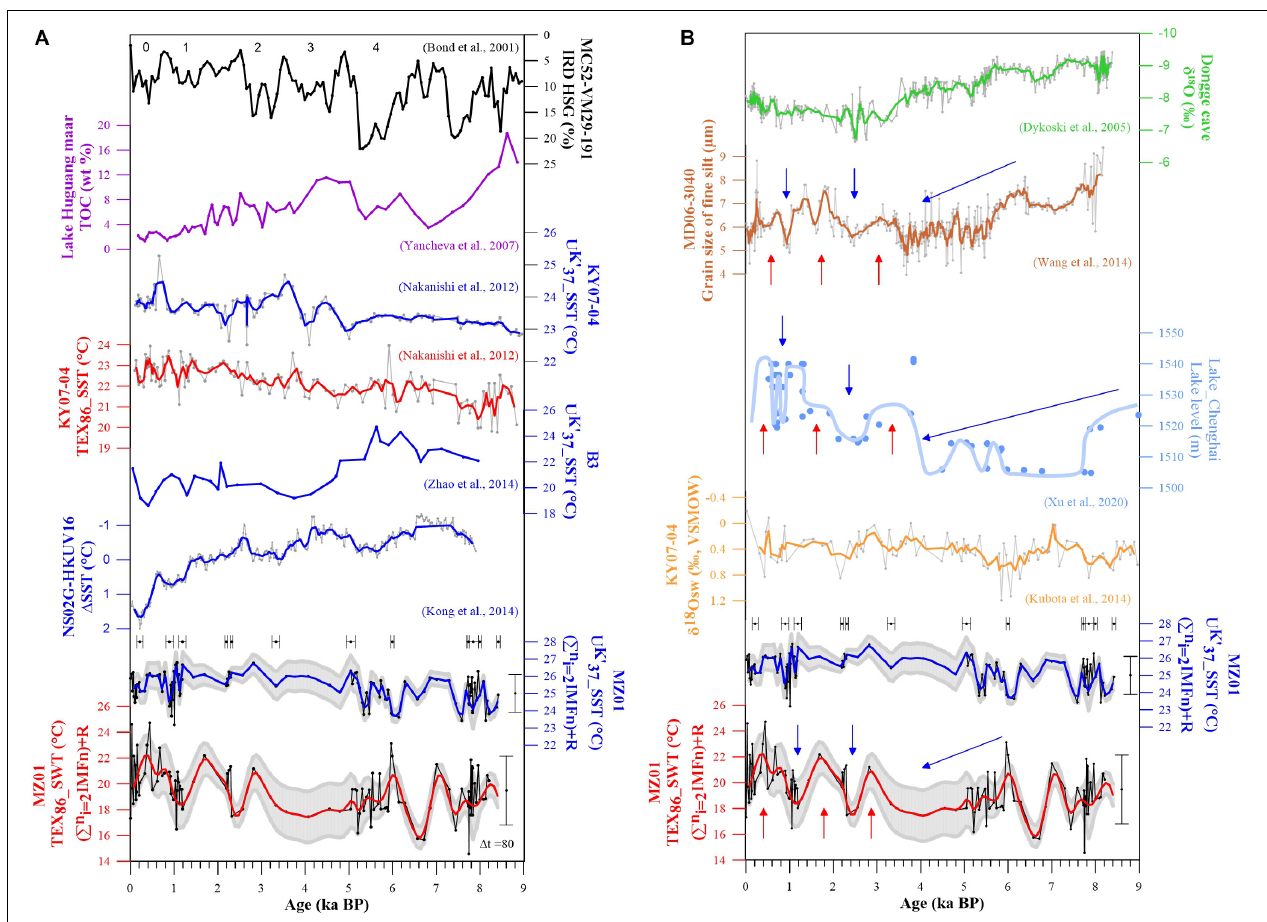
FIGURE 3 | (A) from top to bottom: the variations of hematite-stained grains derived from ice-rafted debris in the North Atlantic (Bond et al., 2001), total organic carbon content in Lake Huguang Maar (Yancheva et al., 2007), U K (cid:48) 37 -SST and TEX 86 -derived temperature of core KY07-04 in East China Sea (ECS; Nakanishi et al., 2012), U K (cid:48) 37 -SST of core B3 in the continental shelf of the ECS (Zhao et al., 2014), and the temperature difference between sites HKUV16 and NS02G neighboring Pearl River estuary (Kong et al., 2014). (B) from top to bottom: the fluctuations of δ 18 O in Dongge Cave (Dykoski et al., 2005), fine silt grain size of core MD06-3040 from mud belt off the Zhejiang-Fujian coast on the inner shelf of ECS (Wang et al., 2014), lake level variation of Chenghai (Xu et al., 2020), and δ 18 O of core KY07-04 (Kubota et al., 2015). The gray curves represent the original data before 3-points smoothing. The last two curves in both (A) and (B) display the U K (cid:48) 37 and TEX 86 -derived temperature of core MZ01. The gray strip region indicates the temperature range generated from CSECM conversion ( Supplementary Material Part 3